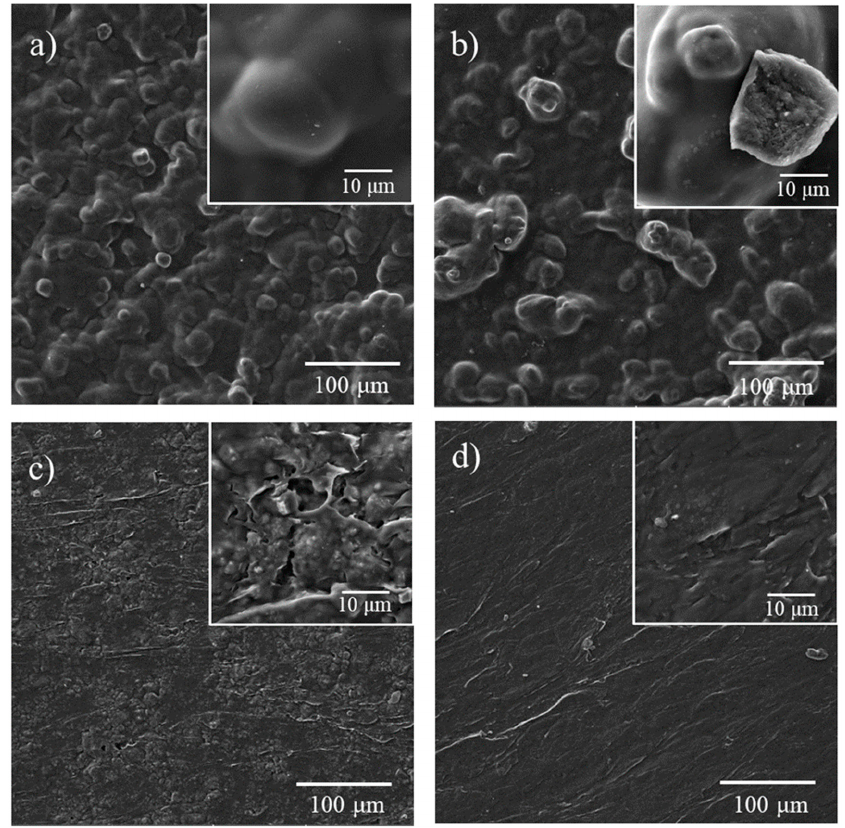
Figure 3. SEM images of the ( a ) control SC film, ( b ) SCT film with 10.08% of thymol, ( c ) control SCZ (30%) and ( d ) SCZT (30%) film with 24% of thymol. (30%) and ( d ) SCZT (30%) film with 24% of